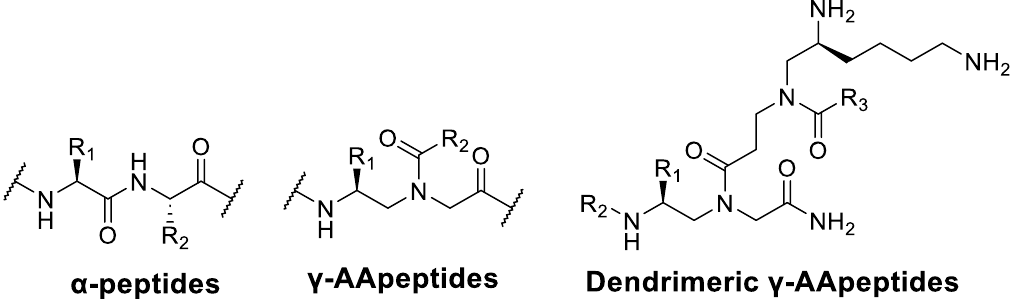
Figure 1. Structures of α-peptides, γ-AApeptides, and dendrimeric γ-AApeptides.